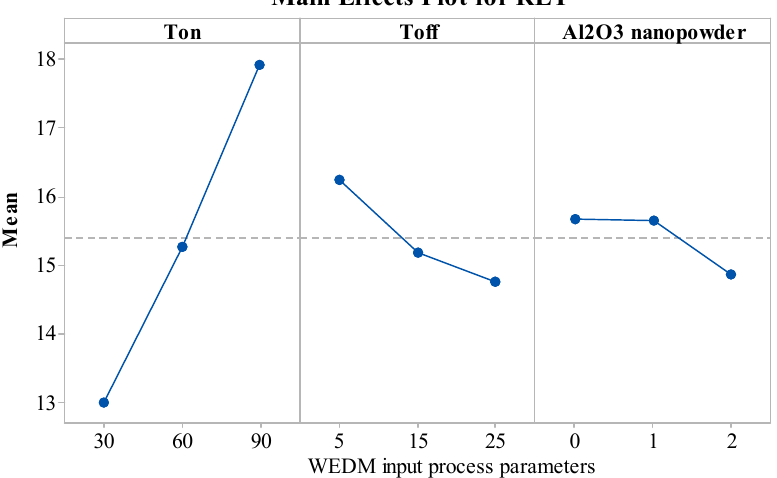
Figure 5. Effect of input process parameters on RLT.